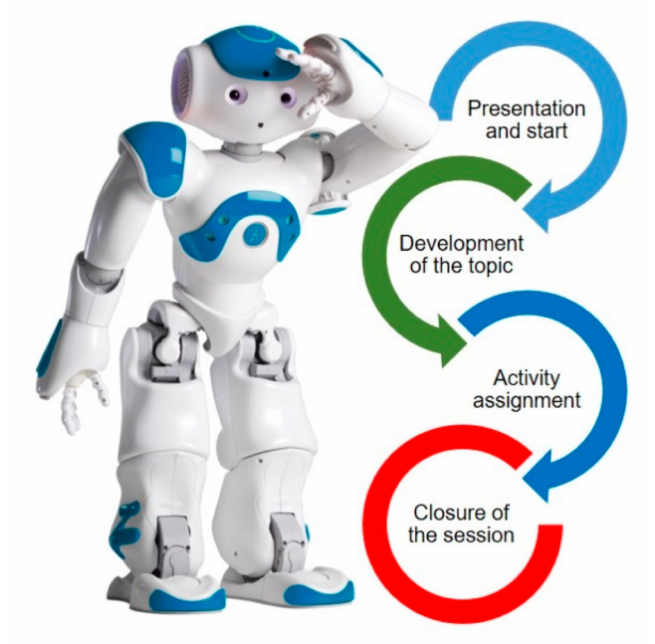
Figure 2. Structure of the